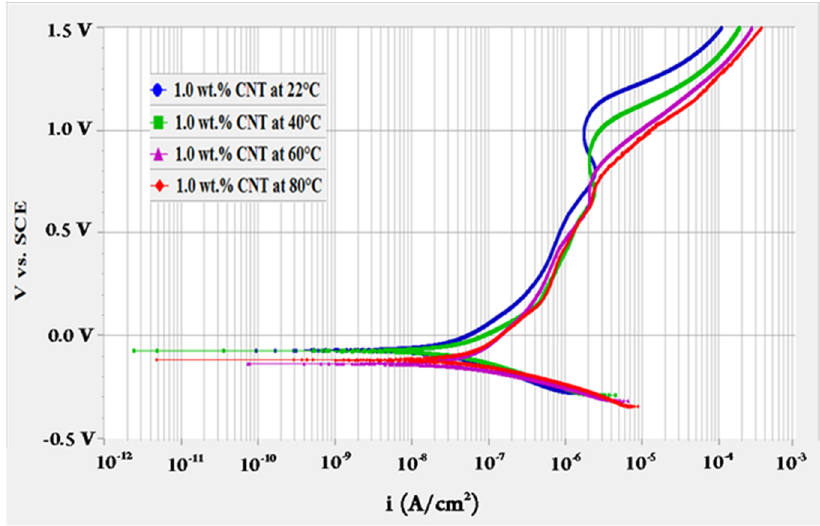
Figure 1. Potentiodynamic scan for 316L stainless steel tested in 0.1 wt.% CNTs + 0.3 wt.% GA in deionized water nanofluids at different temperatures.